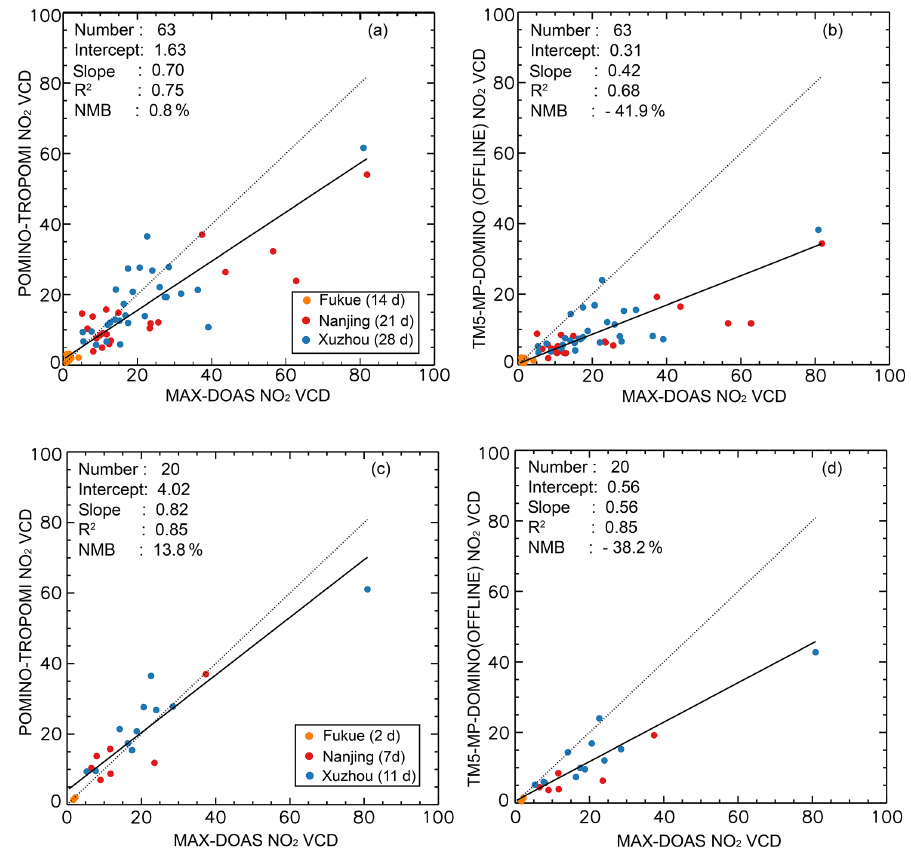
Figure 6. Scatterplot for daily NO 2 VCDs (10 15 molec.cm − 2 ) between MAX-DOAS and two TROPOMI NO 2 VCD products. Each colored dot represents a day, and each color denotes a station. For each day, the satellite data are averaged over all pixels. Panels (c) and (d) are results of two TROPOMI NO 2 VCD products with effective cloud pressures ≤